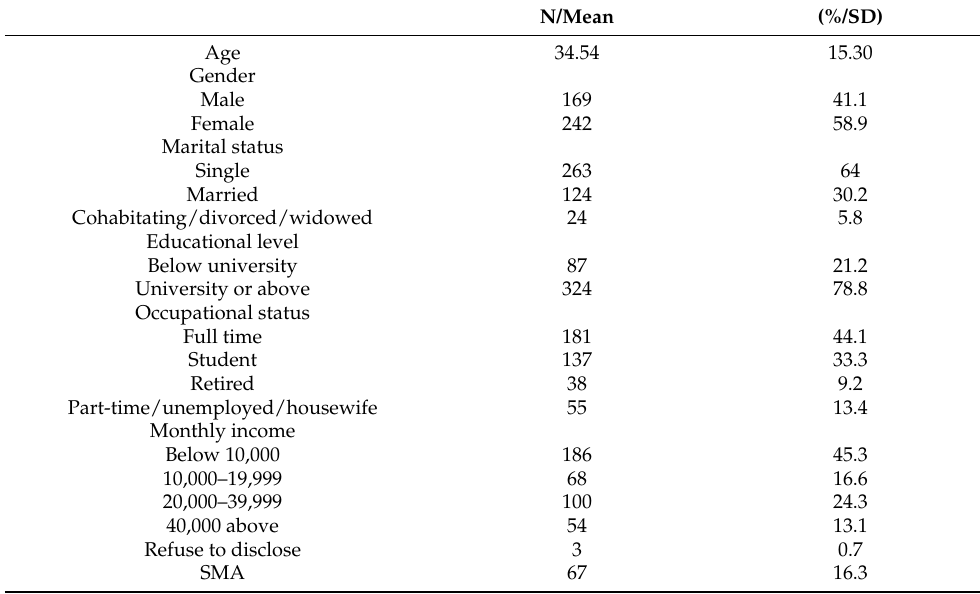
Table 1. Background characteristics of the participants (N =